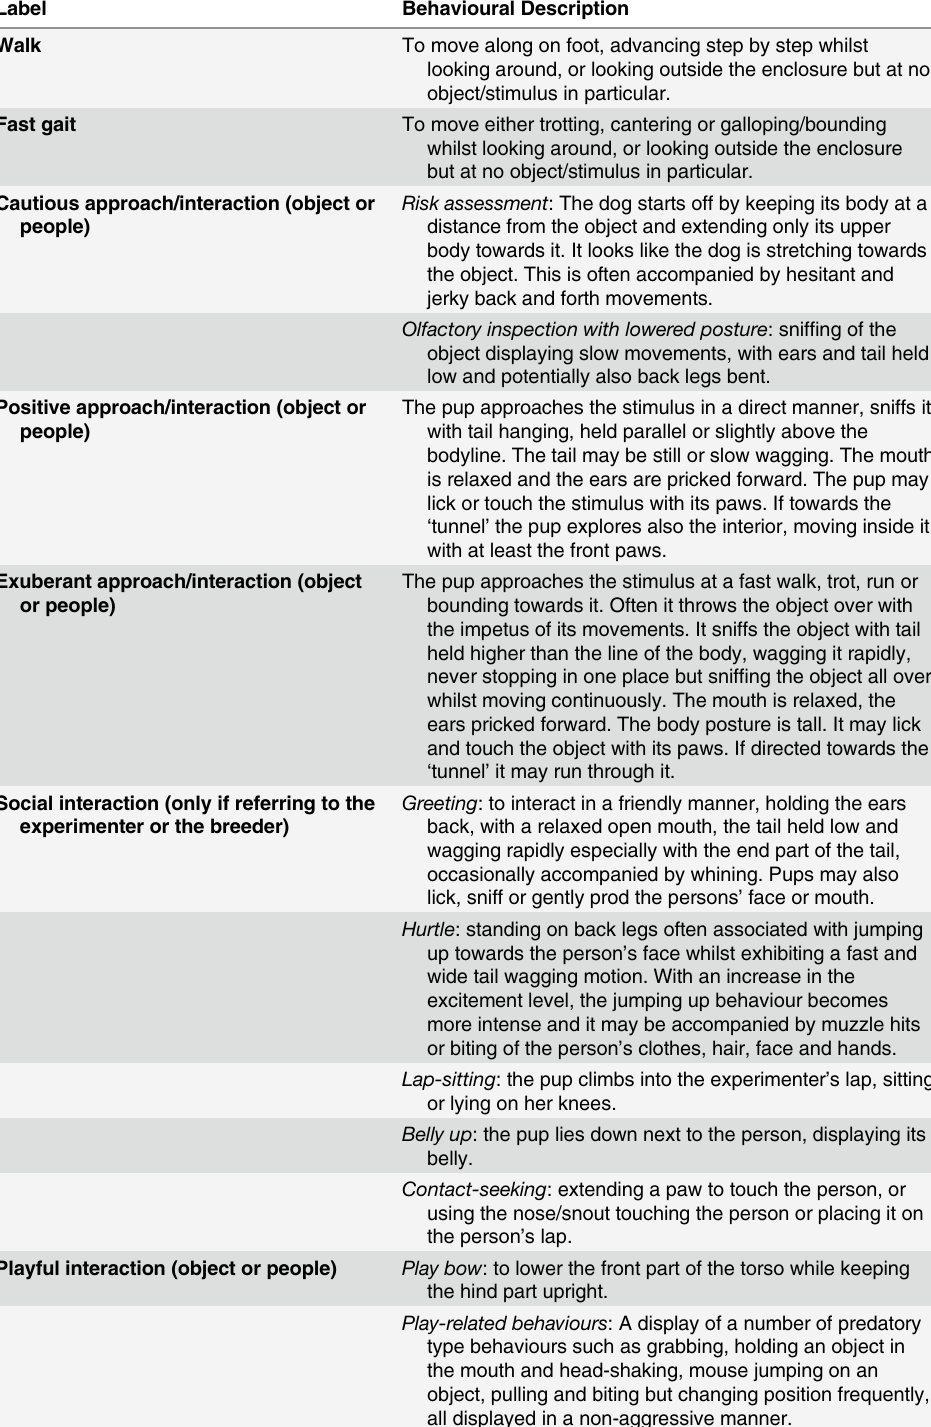
Table 3. Behavioural variables recorded during the